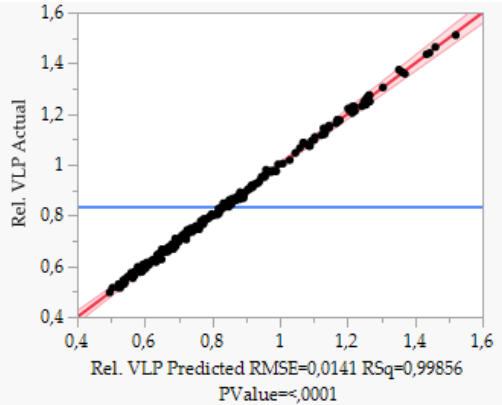
Figure 6. Actual by predicted plot of DoE simulations for normalized HIV-Gag VLP concentration.